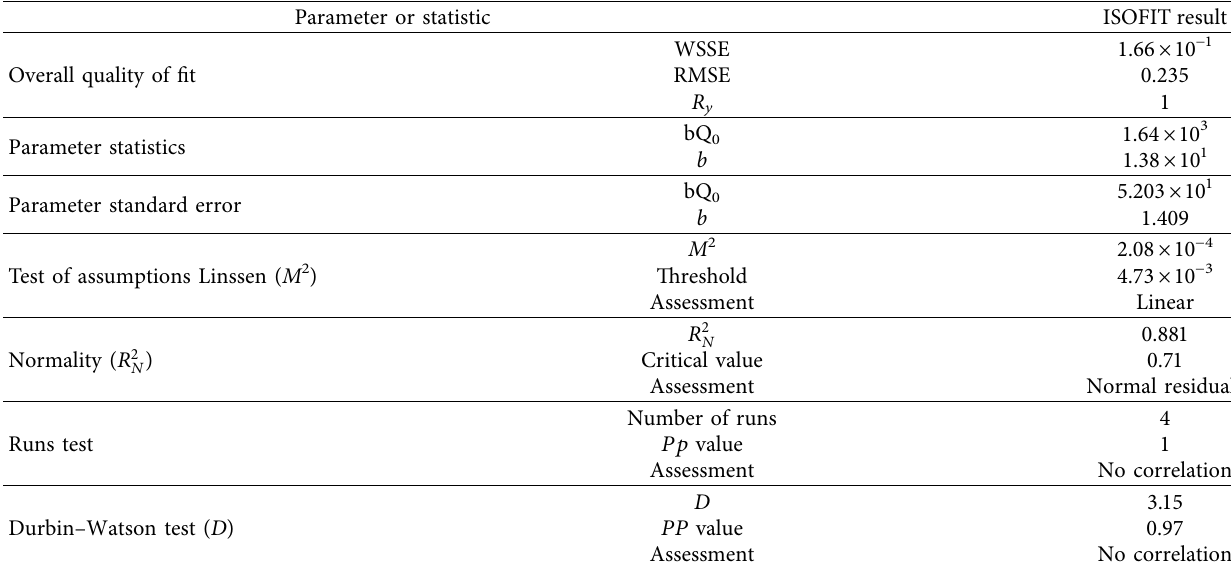
Figure 6: (a) Plot of pseudo-first-order, (b) pseudo-second-order, and (c) intraparticle diffusion kinetic models for ATN adsorption onto M-MWCNTs. Table 6: Selected ISOFIT postregression